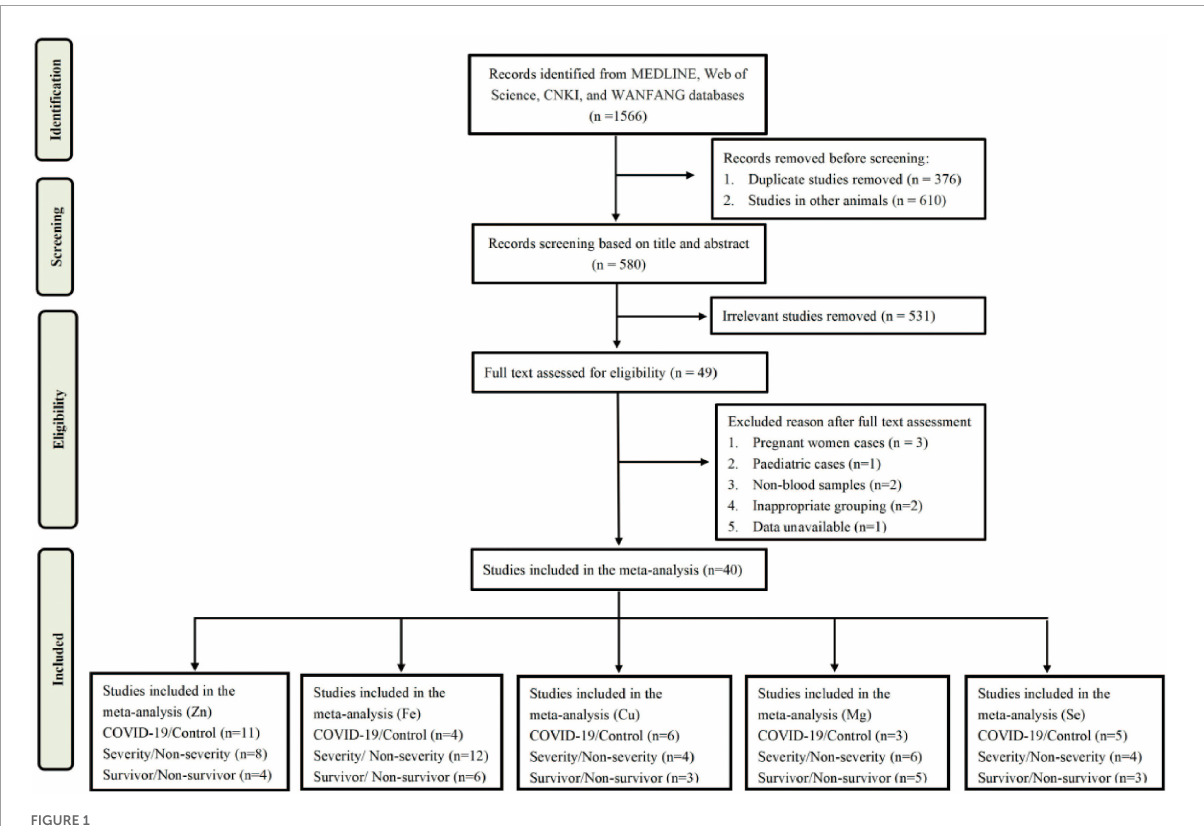
FIGURE1 Flow diagram of the study selection